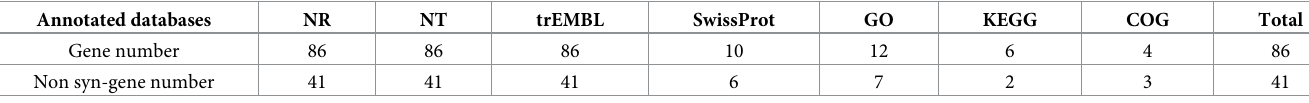
Table 3. Statistics of gene function annotation results in candidate regions. Annotated